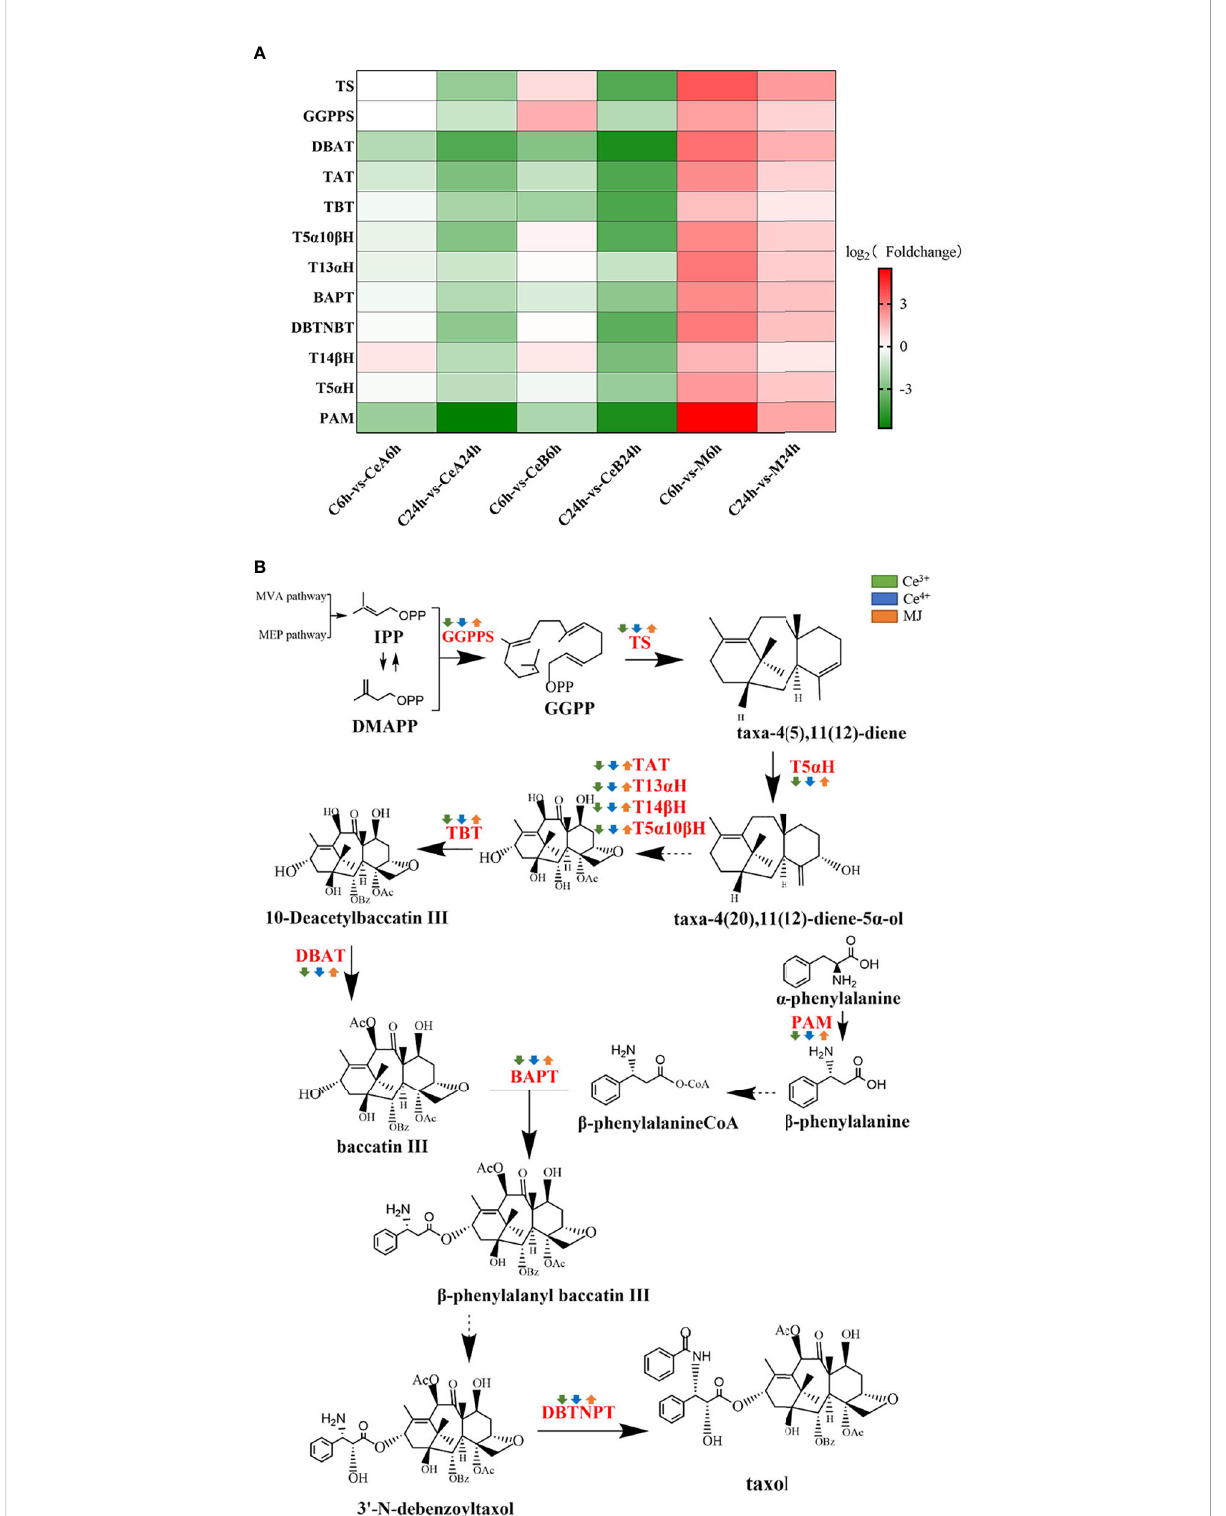
FIGURE 7 (A) Comparison of DEGs in taxol biosynthesis pathway. The color density indicated log 2 (Foldchange). Red indicated the upregulation of gene expression and green indicated the downregulation of gene expression. (B) DEGs assigned to the taxol biosynthesis pathway. Green is elicited by Ce3+, blue is Ce4+, orange is MJ. The up arrows indicate the upregulation of gene expression; the down arrows indicate the downregulation of gene